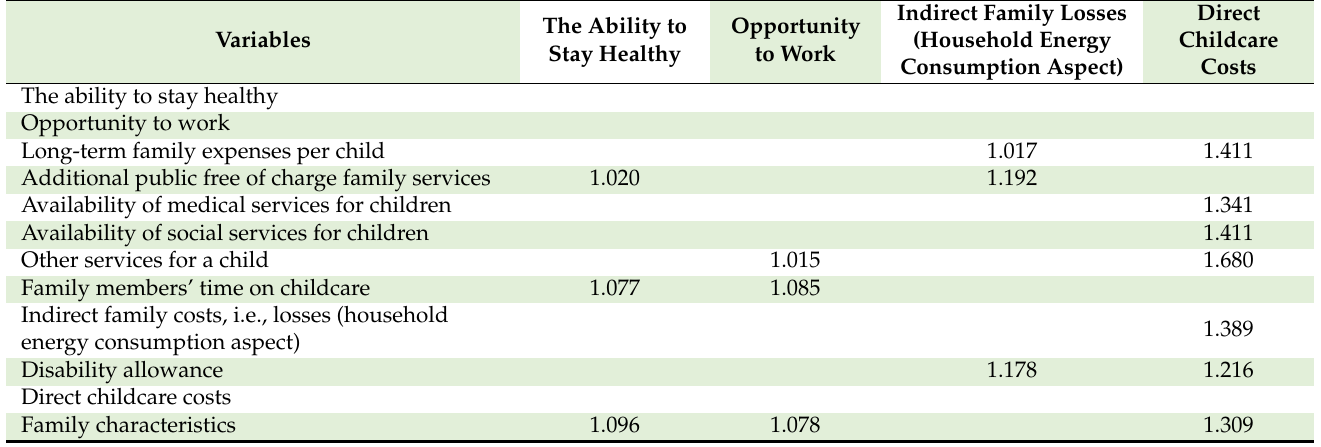
Table 3. Collinearity statistics